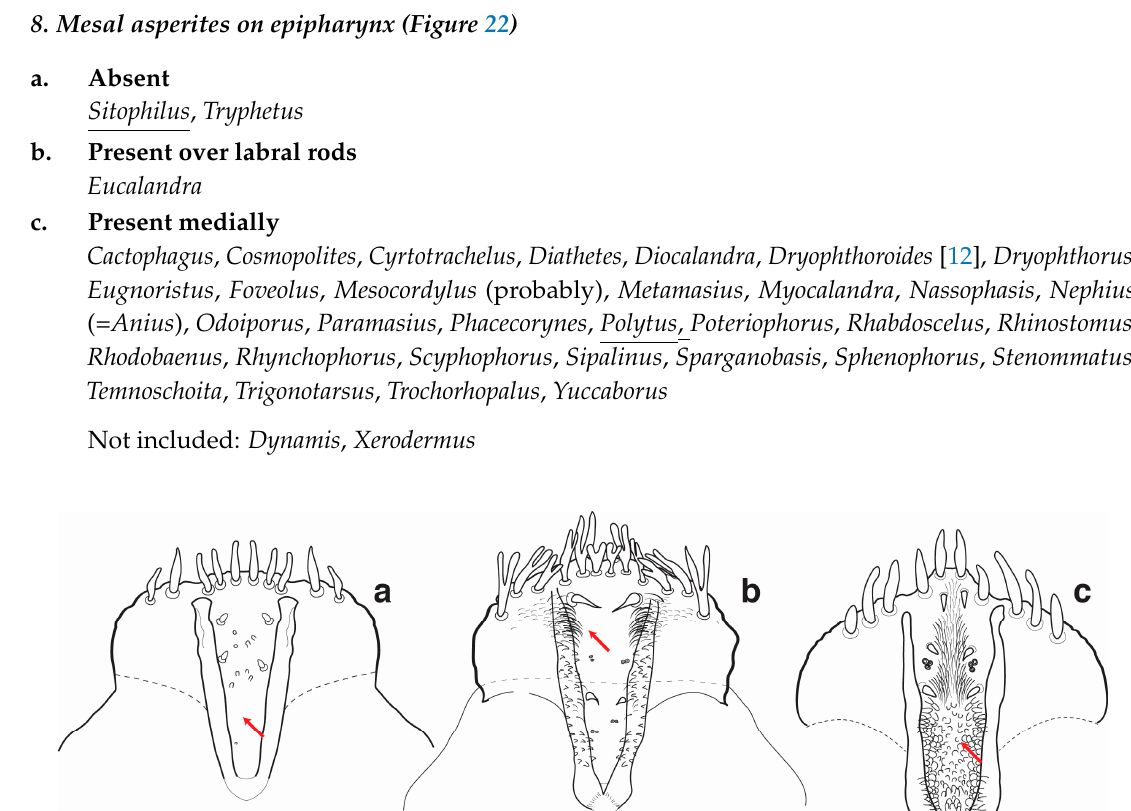
Figure 22. Epipharynx, larva: ( a ) Sitophilus ; ( b ) Eucalandra ; and ( c ) Polytus .